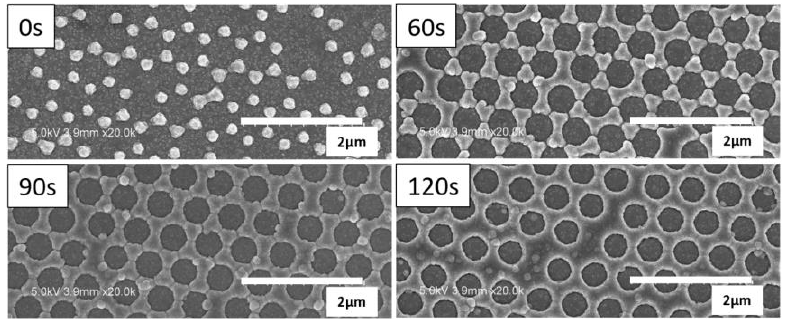
Figure 5. SEM images of hexagonal Ag/ZnO back reflectors obtained with 0, 60, 90, and 120 s of O 2 plasma treatment of polystyrene spheres (See Figure 1a for process flow).